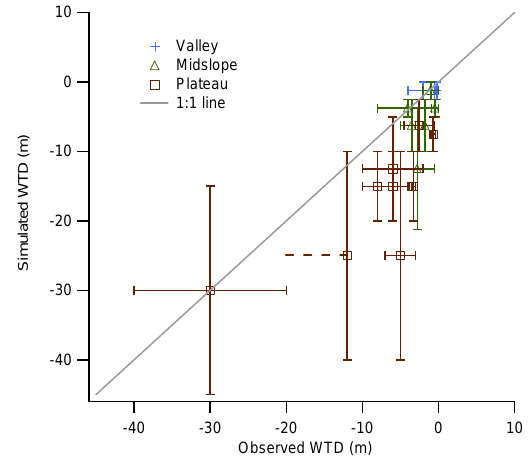
Fig. 11. Comparison of simulated and observed water table depth (m) at the nine sites (data in table 3).